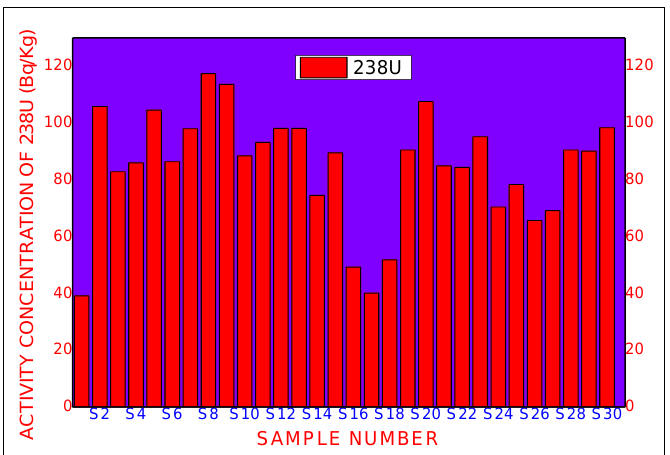
Figure 3: Activity Concentrations of 238U in the Collected Tailing Samples.